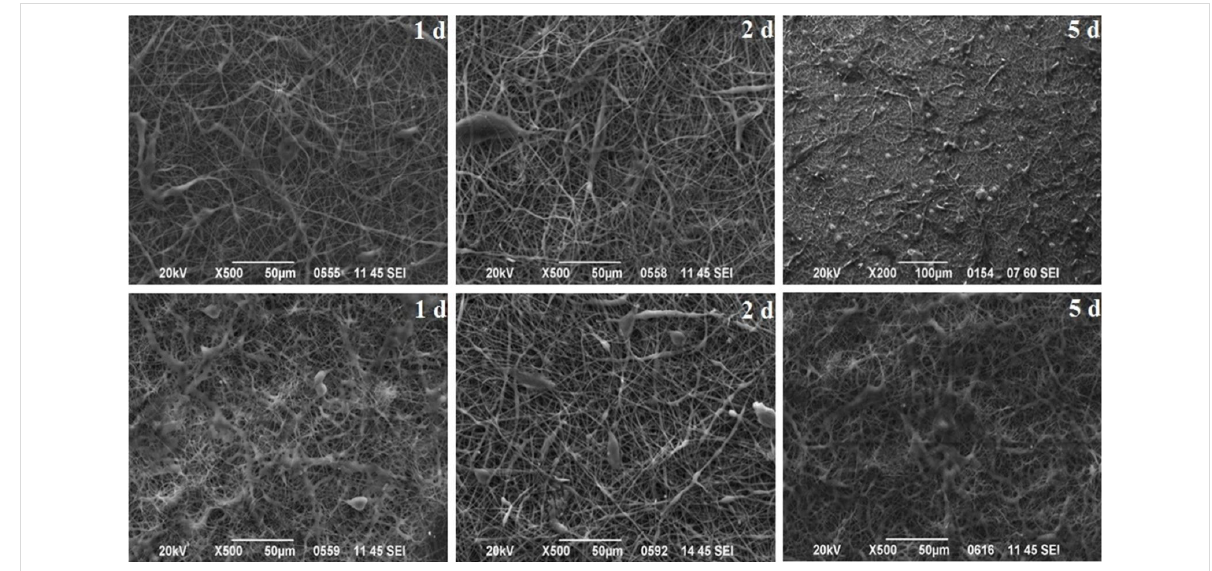
Figure 10: SEM micrograph of L929 cells on the examined scaffolds. The three pictures in the top row display the CA scaffolds, while the three pictures in the bottom row indicate the CA:dexam scaffolds after the 1st, 2nd and 5th day, respectively.